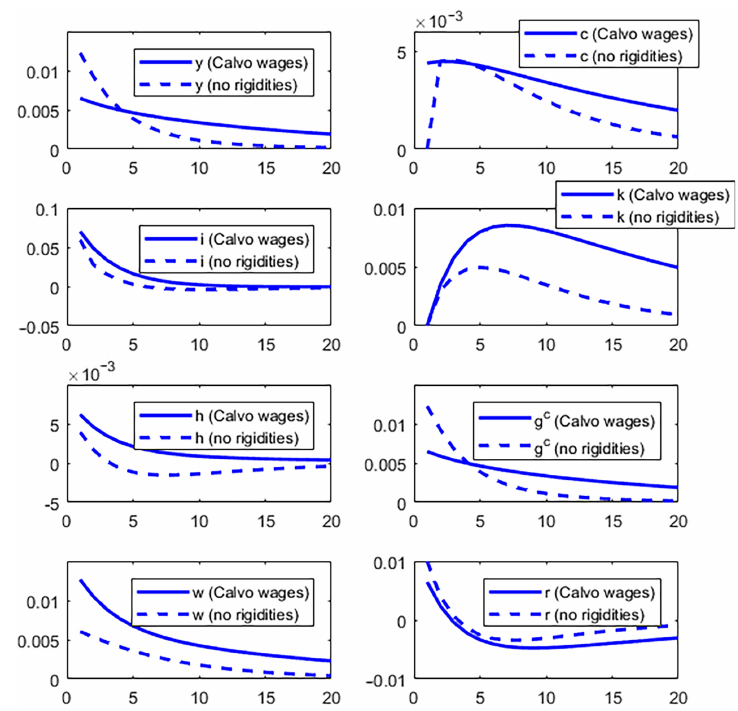
Figure 1. Impulse responses to a 1% surprise innovation